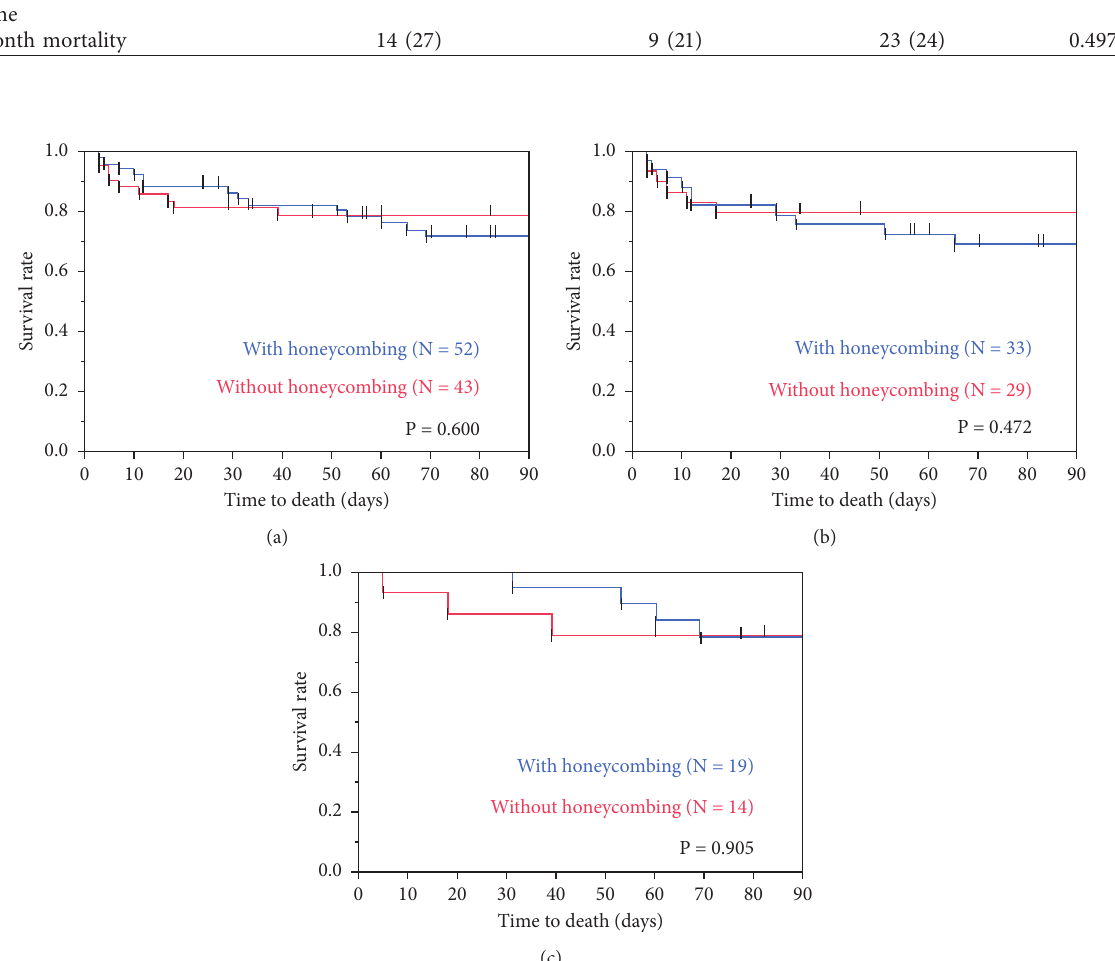
Figure 2: Comparison of patients with and without honeycombing. There is no significant difference in 3-month mortality between those with and without honeycombing in patients with AEs of idiopathic ILDs, AEs of secondary ILDs, and overall patients. AE, acute ex- acerbation; ILD, interstitial lung disease. (a) Overall. (b) Idiopathic. (c)